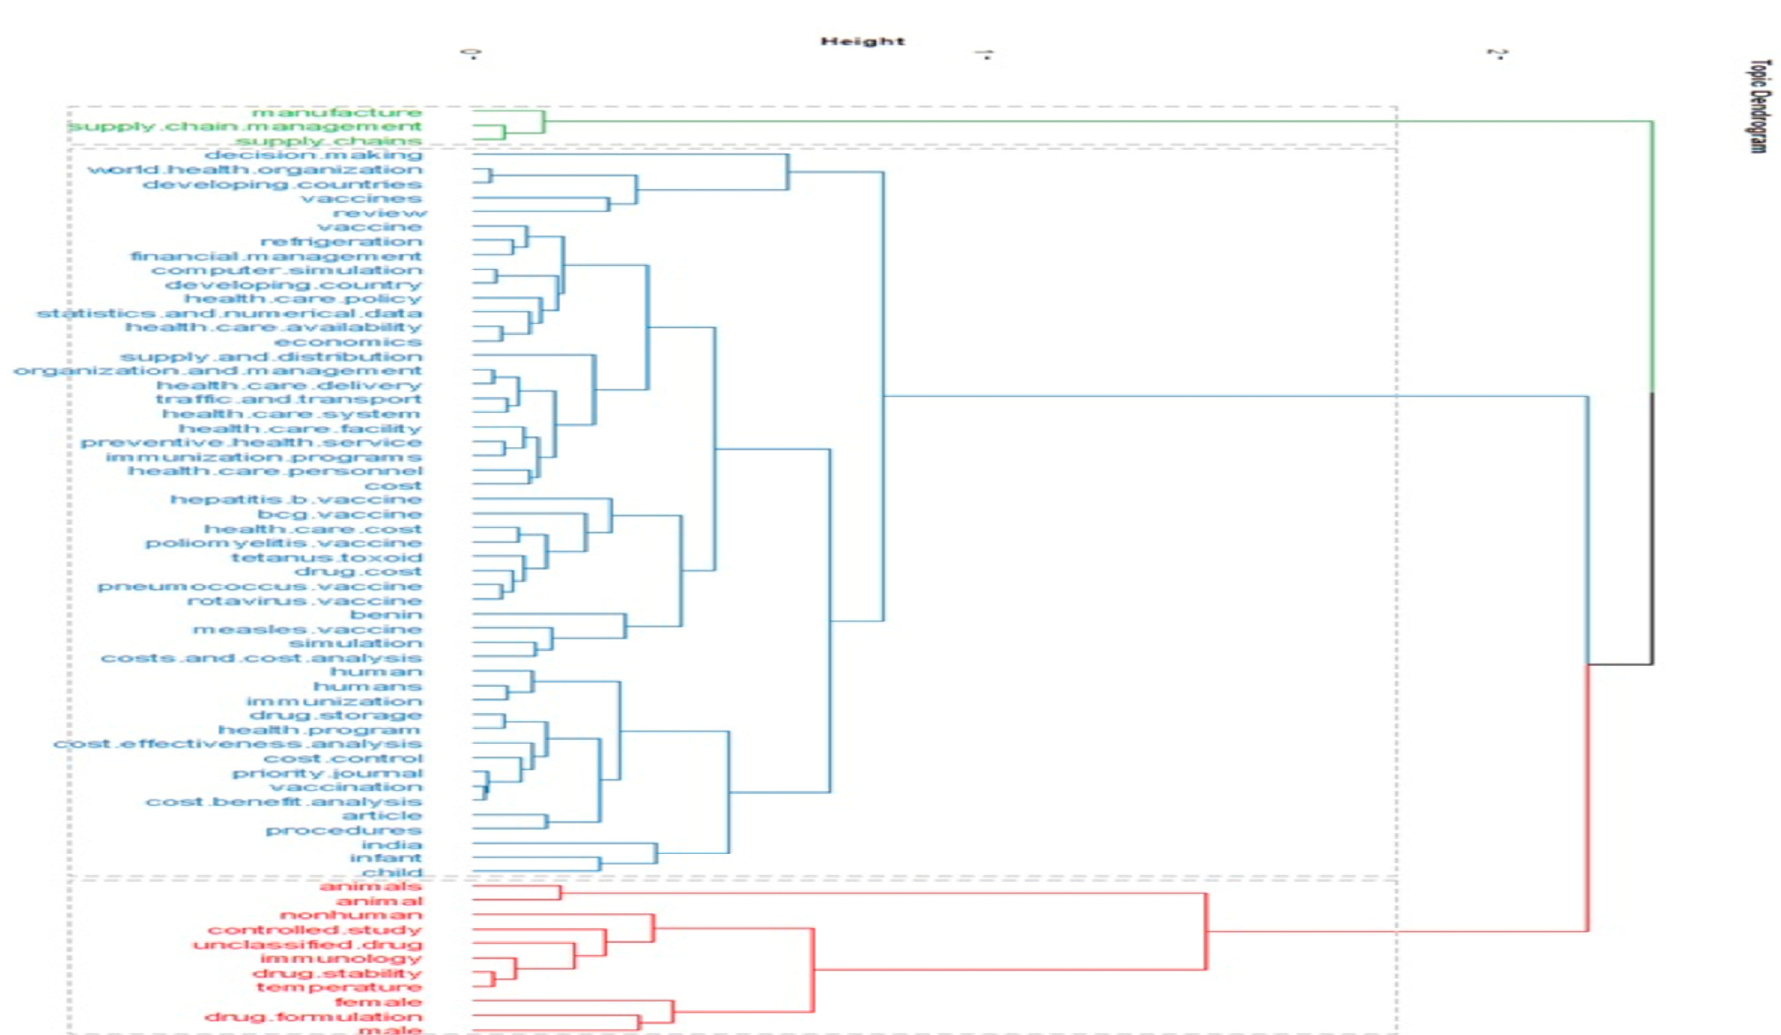
Figure 9. Dendrogram of hierarchical cluster analysis of keywords in the area of VSCM.